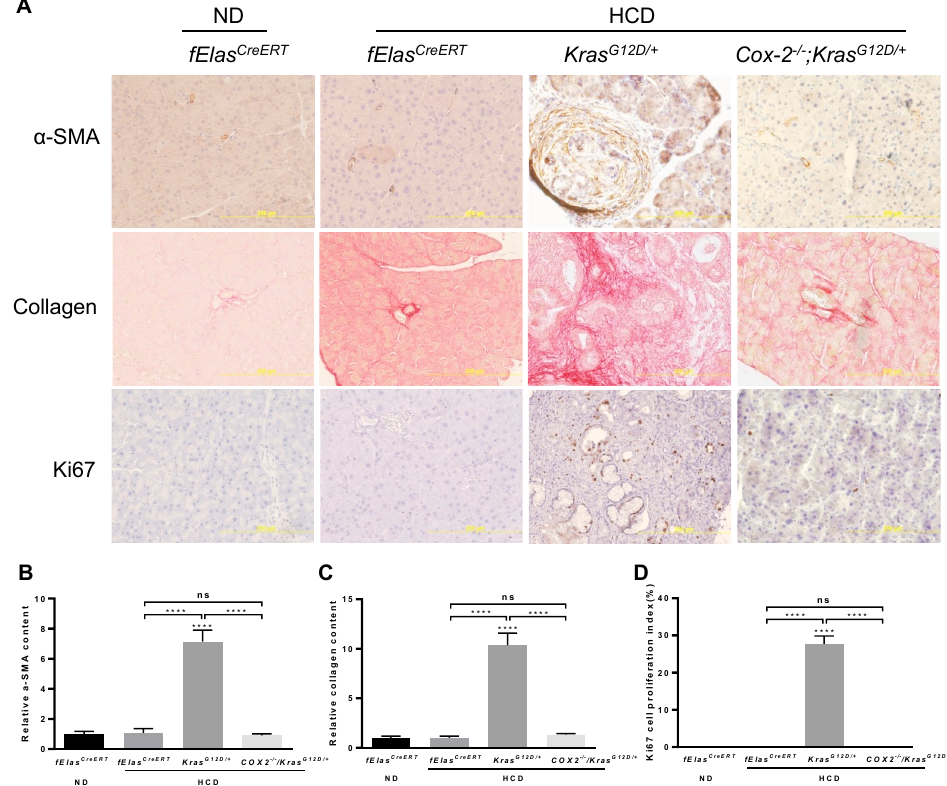
Figure 6. Effects of COX-2 deficiency on the HCD and KRAS G12D/+ mediated pancreatic fibrosis and cell proliferation. ( A ) IHC analyses of mouse pancreata from the indicated four groups with antibodies against α -SMA and Ki67, as well as Sirius Red staining for collagen deposition. Magnification: 200 × . ( B , C ) Quantification of α -SMA and Sirius Red stains with Fiji ImageJ software. ( D ) Quantification of Ki67 staining by manually counting positively stained nuclei of ductal cells. NS, not significant. ****, p -value < 0.0001.